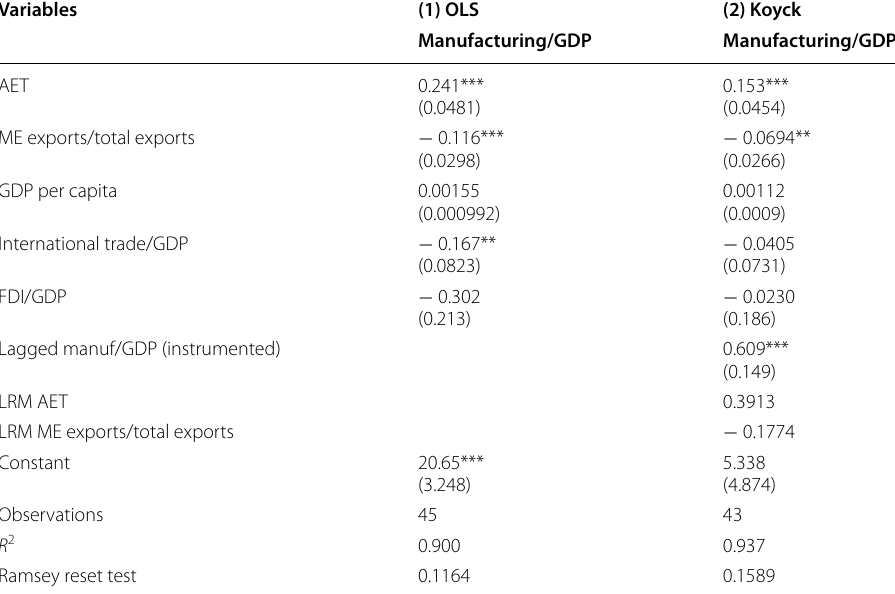
Standard errors in